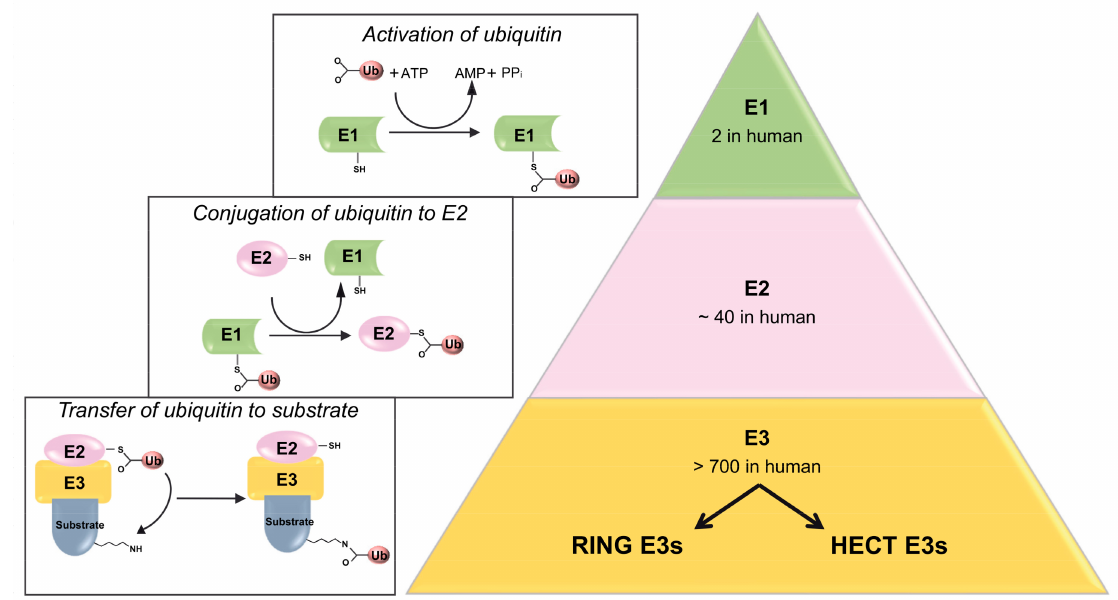
Figure 1. Ubiquitylation process. Ubiquitin (Ub) is attached to substrates by a cascade of reactions involving three enzymes. An E1 enzyme activates Ub in an ATP-dependent way. An E2 enzyme binds and then transfers the activated Ub to a substrate specifically bound to an E3 ligase. E3 enzyme can be divided into two main families: the RING and the HECT E3 ligases. Although, the ubiquitylation process usually leads to the degradation of the substrate, it can also drive regulative